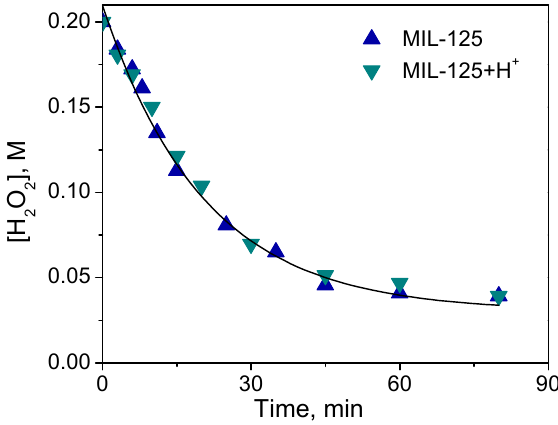
Figure 6. H 2 O 2 decomposition in the presence of MIL-125. Reaction conditions: H 2 O 2 0.4 mmol, catalyst 0.04 mmol Ti, HClO 4 0.04 mmol (if any), CH 3 CN 2 mL, 50 °C.